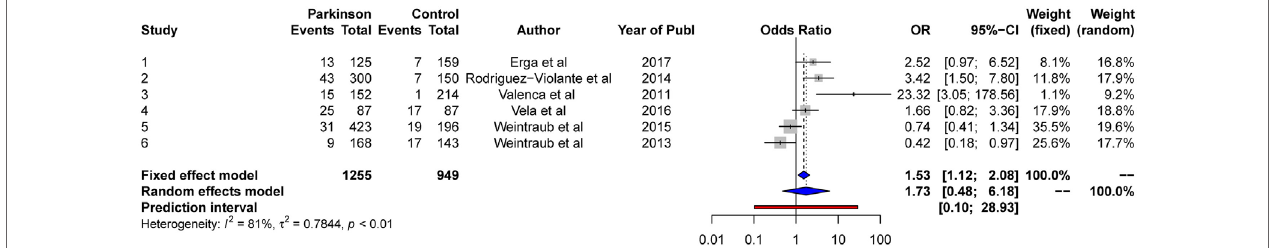
FigURe 13 | Forest plot for